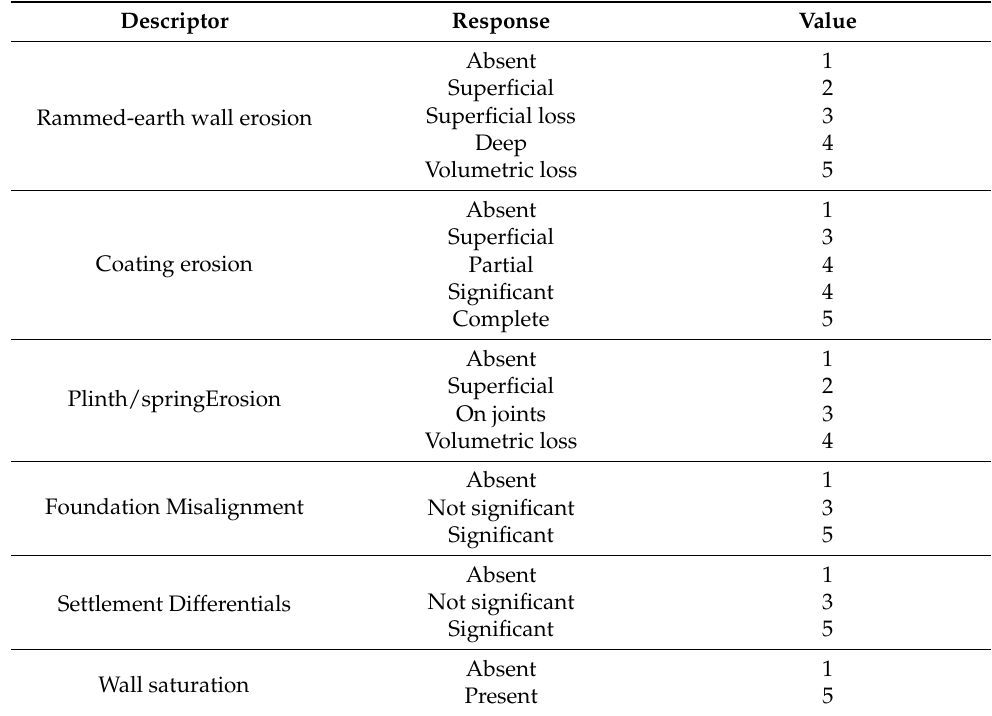
Table 4. Material weathering and structural damage descriptor ratings.